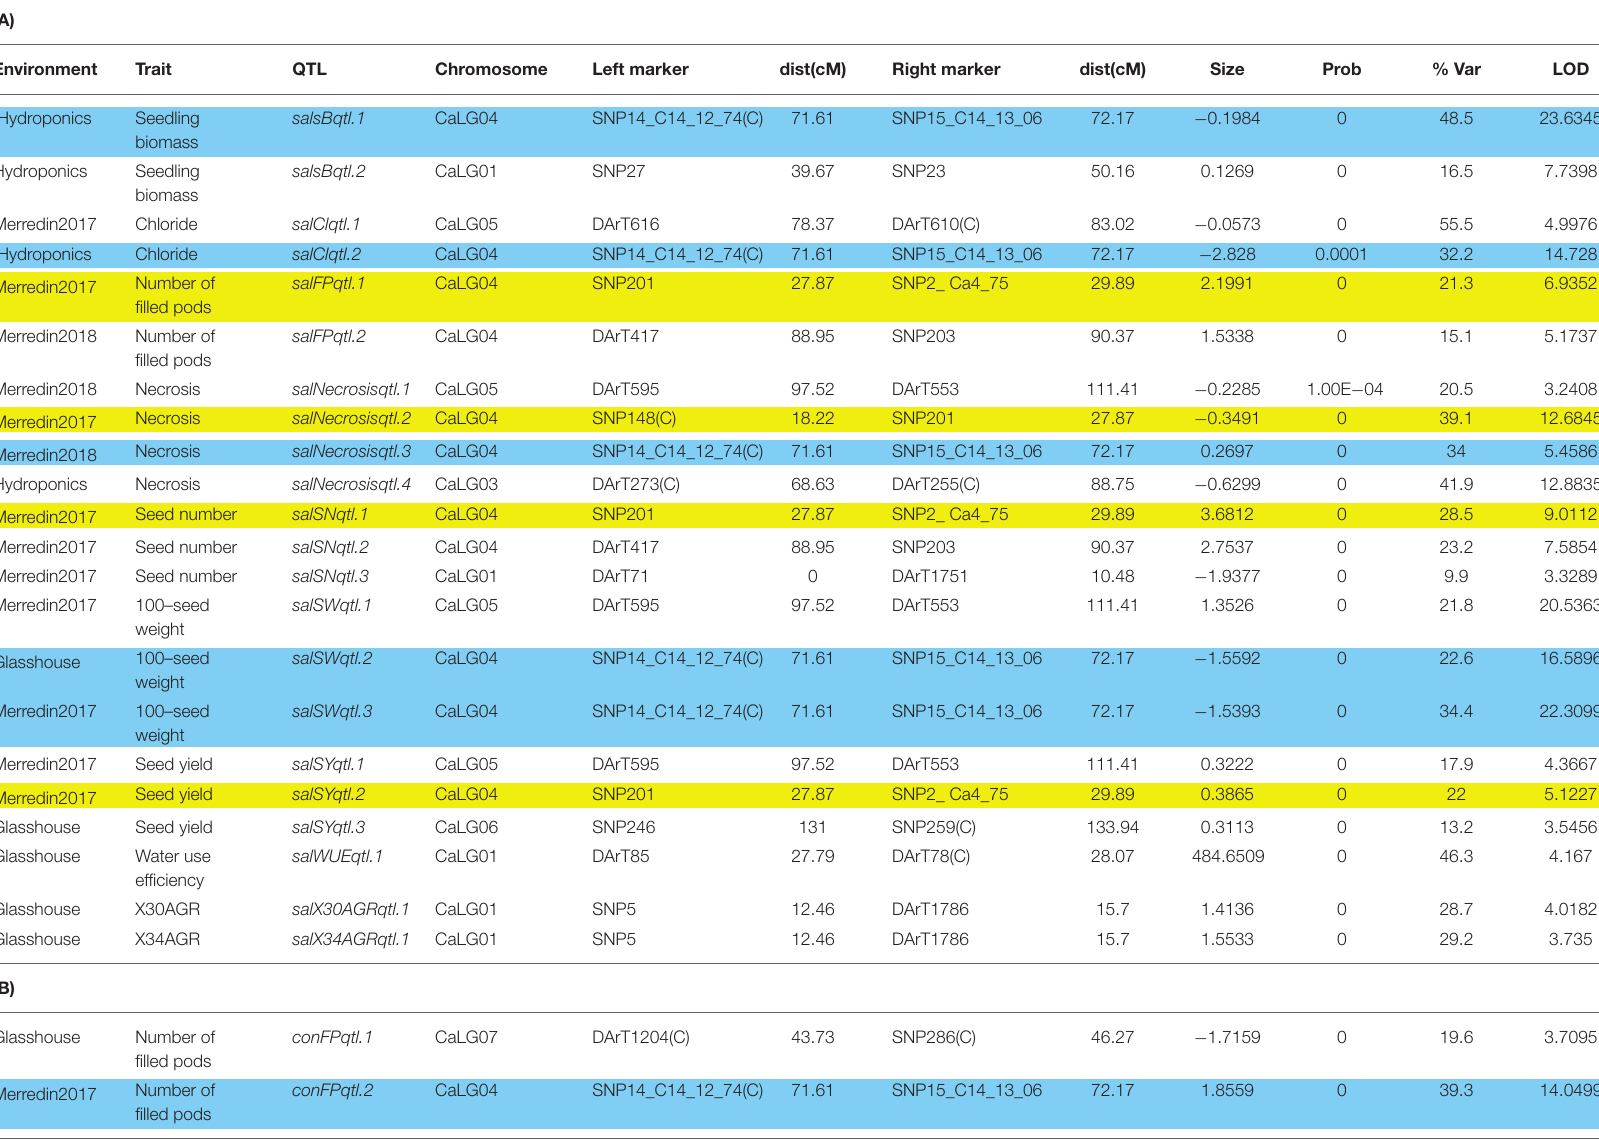
TABLE 5 | Quantitative trait loci (QTL) associated with various traits measured across different environments including hydroponics, glasshouse and two field experiments (Merredin2017 and Merredin2018) under (A) saline and (B) control conditions QTL highlighted in blue and yellow represent major loci on CaLG04 controlling inherent growth-related traits and salinity specific traits, respectively.